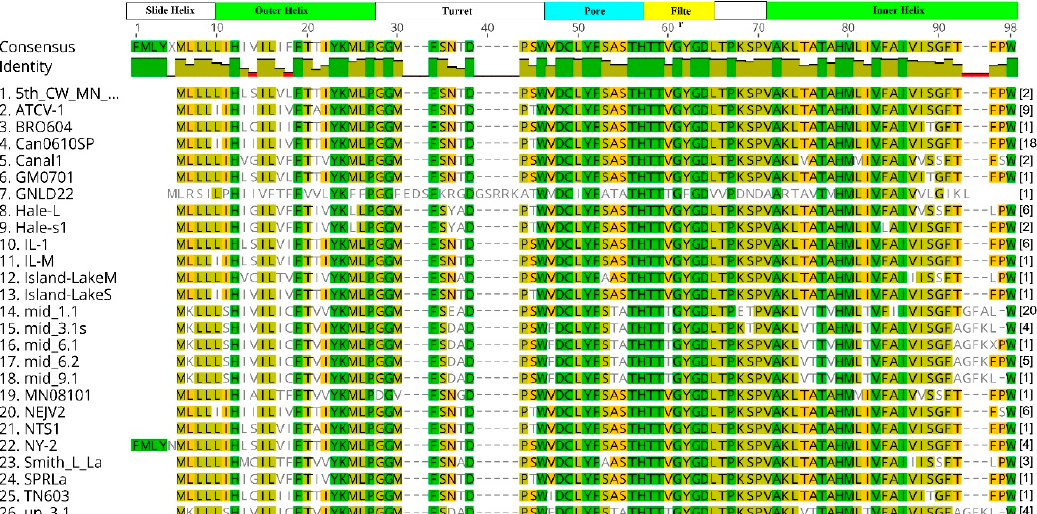
Figure 2. Amino acid alignment of SAG chlorovirus unique Kcv proteins using Geneious 11.0.5 software. The number in brackets at the end of each protein is the number of times that the protein had an identical sequence of the 103 viruses examined. Score matrix is Identity. Green color denotes identical amino acids. Other shades of amino acids indicate a level of conservation from olive color as being the most conserved to white color not conserved.